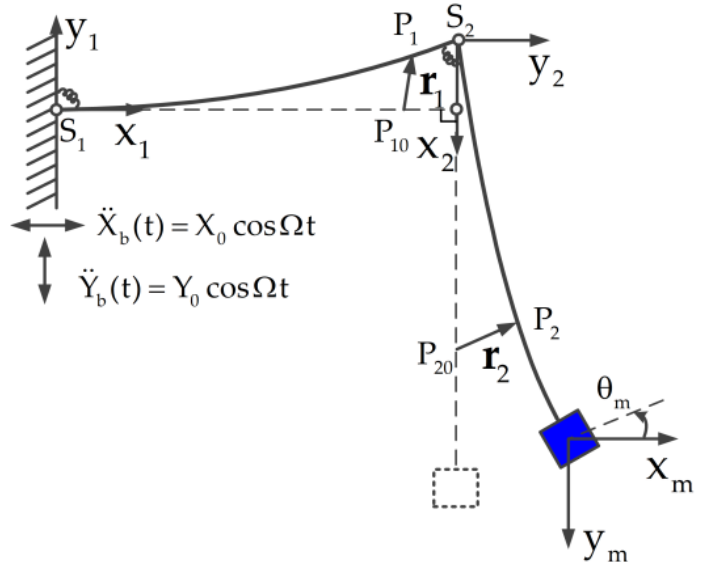
Figure 1. Schematic of the L-shaped multi-beam jointed structure with tip mass. The deformation of arbitrary points P 10 and P 20 on the horizontal beam and the vertical beam, respectively, are depicted in Figure 1. After the deformation, the positions